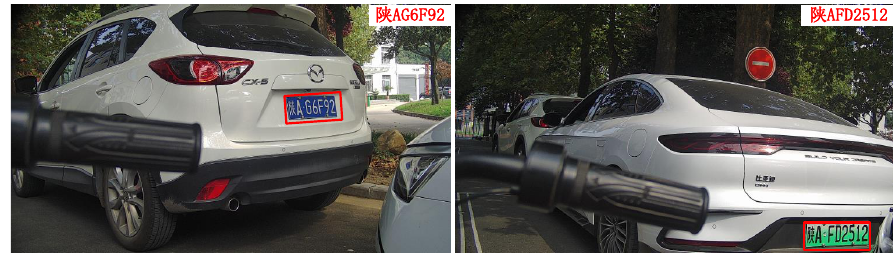
Figure 7. Portable intelligent inspection robot.